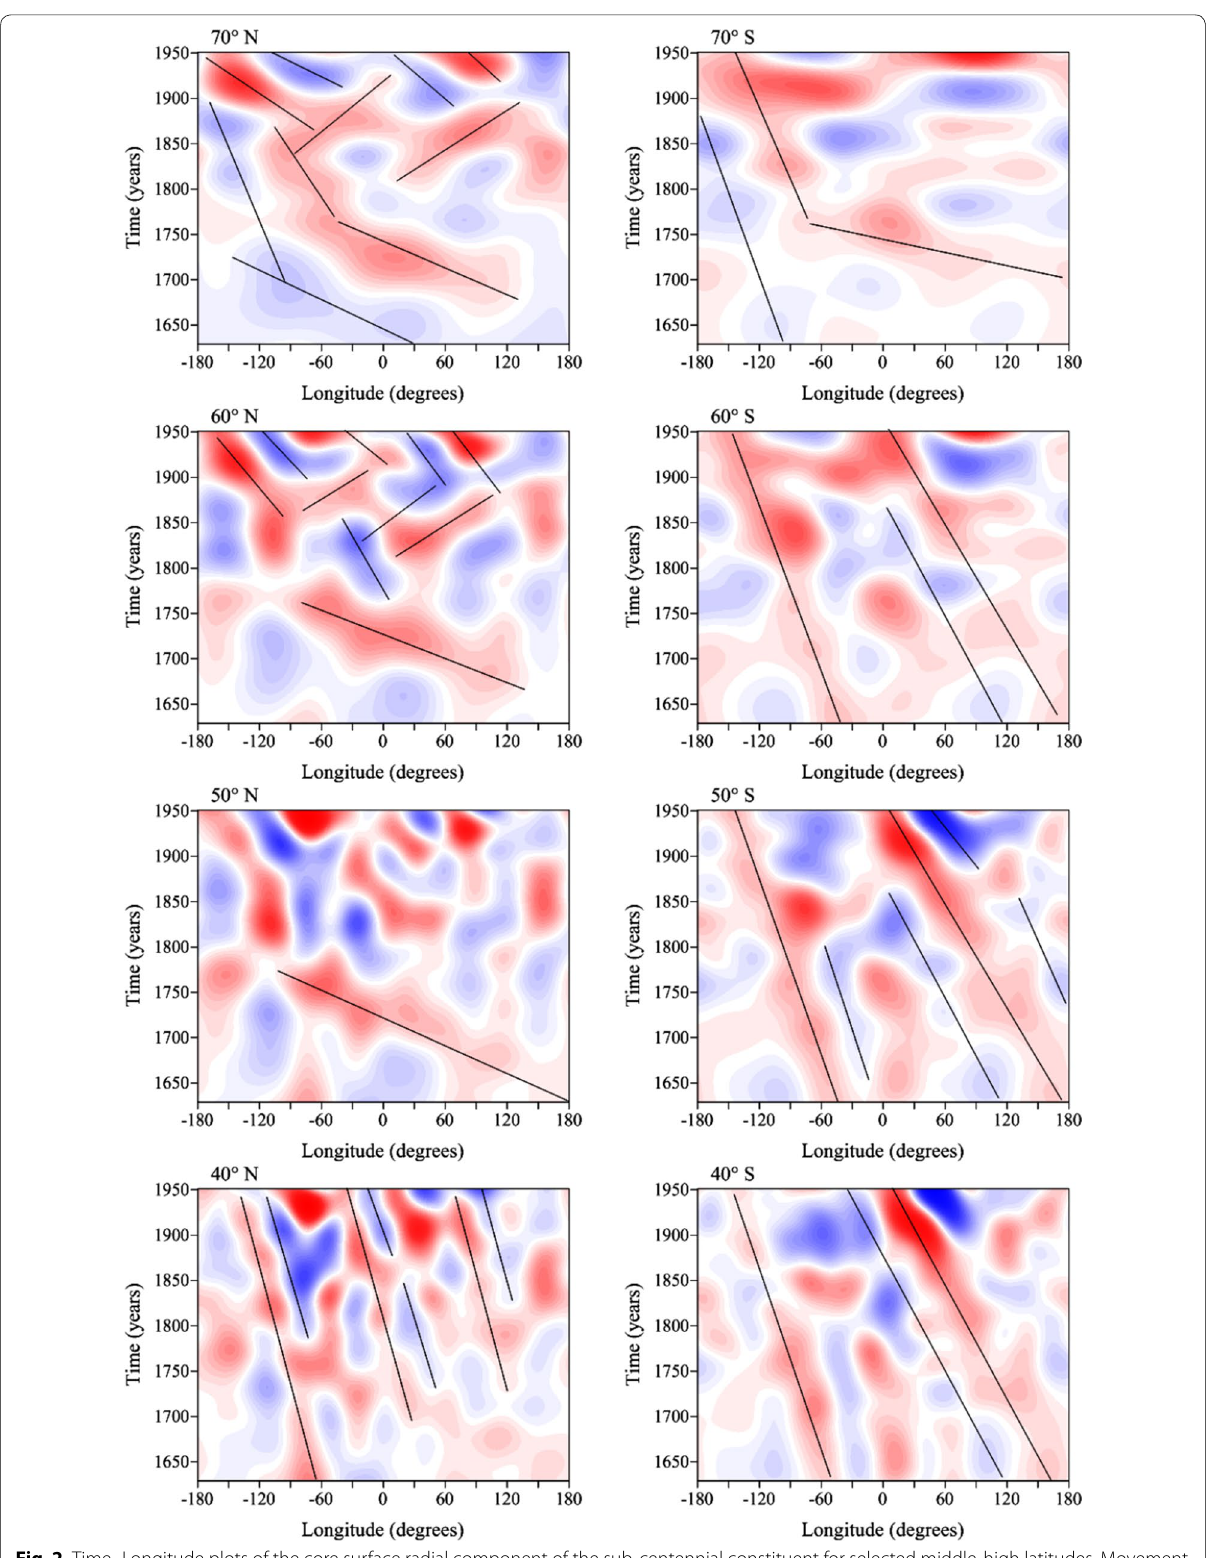
Fig. 2 Time–Longitude plots of the core surface radial component of the sub-centennial constituent for selected middle-high latitudes. Movement direction is highlighted by straight line